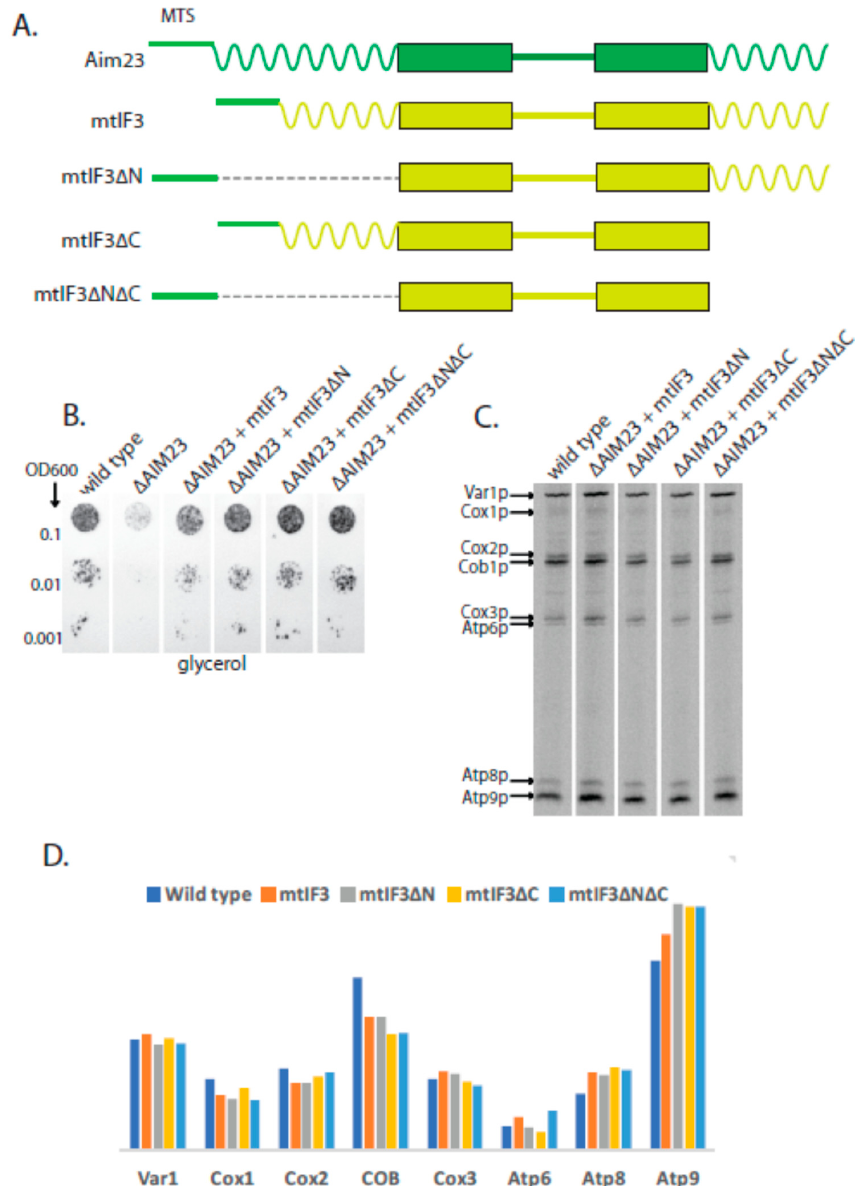
Figure 4. Human mtIF3 does not require any terminal extension to be active in yeast mitochondria. ( A ) Scheme of the hybrid proteins (the names are indicated on the left). The designations of the main structural parts and their colors are the same as in Figure 1. ( B ) The plate with glycerol-containing medium after 2 days of growth of the yeast strains indicated on the top. The ten-fold dilutions of the yeast suspensions were plated, starting from OD600 0.1 (indicated on the left). Wild-type: see Figure 2 legend. All other strains: D273-10B with the AIM23 genomic disruption supplemented with the corresponding human mtIF3 version encoded by the plasmid. The experiment has been biologically repeated three times; the characteristic result is presented. ( C ) Separation of radioactively-labeled products of mitochondrial translation of the yeast strains indicated on the top. Cytosolic translation was inhibited by cycloheximide which was followed by adding of 35 S-methionine incorporated exclusively in the mitochondrially-encoded proteins (for details, see Materials and Methods). The bands corresponding to all the eight individual proteins encoded in yeast mitochondria are visible; the proteins’ names are indicated on the left. ( D ) Estimated levels of the mitochondrially-encoded proteins (indicated on the bottom) after 15 min of labeling with 35 S-methionine in the yeast strains indicated on the top.